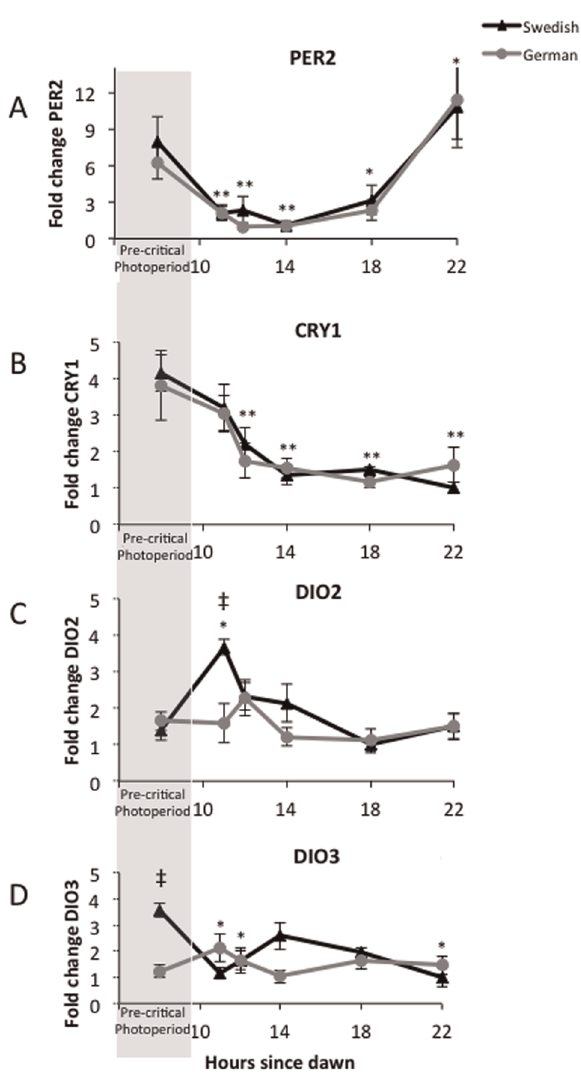
Figure 1. Fold change in mRNA expression of PER2 ( A ), CRY1 ( B ), DIO2 ( C ) and DIO3 ( D ) relative to control genes during exposure to one long day in German and Swedish photosen- sitive great tit males. Both clock genes show similar expression between populations. DIO2 expression increased and DIO3 expression decreased at 11 hours after dawn following pre-threshold sampling times (gray bar) in the Swedish population only. The symbols ** indicate both populations differ from pre-threshold values, and * indicates a single population differs from pre-threshold values, { indicates populations differ significantly from each other.